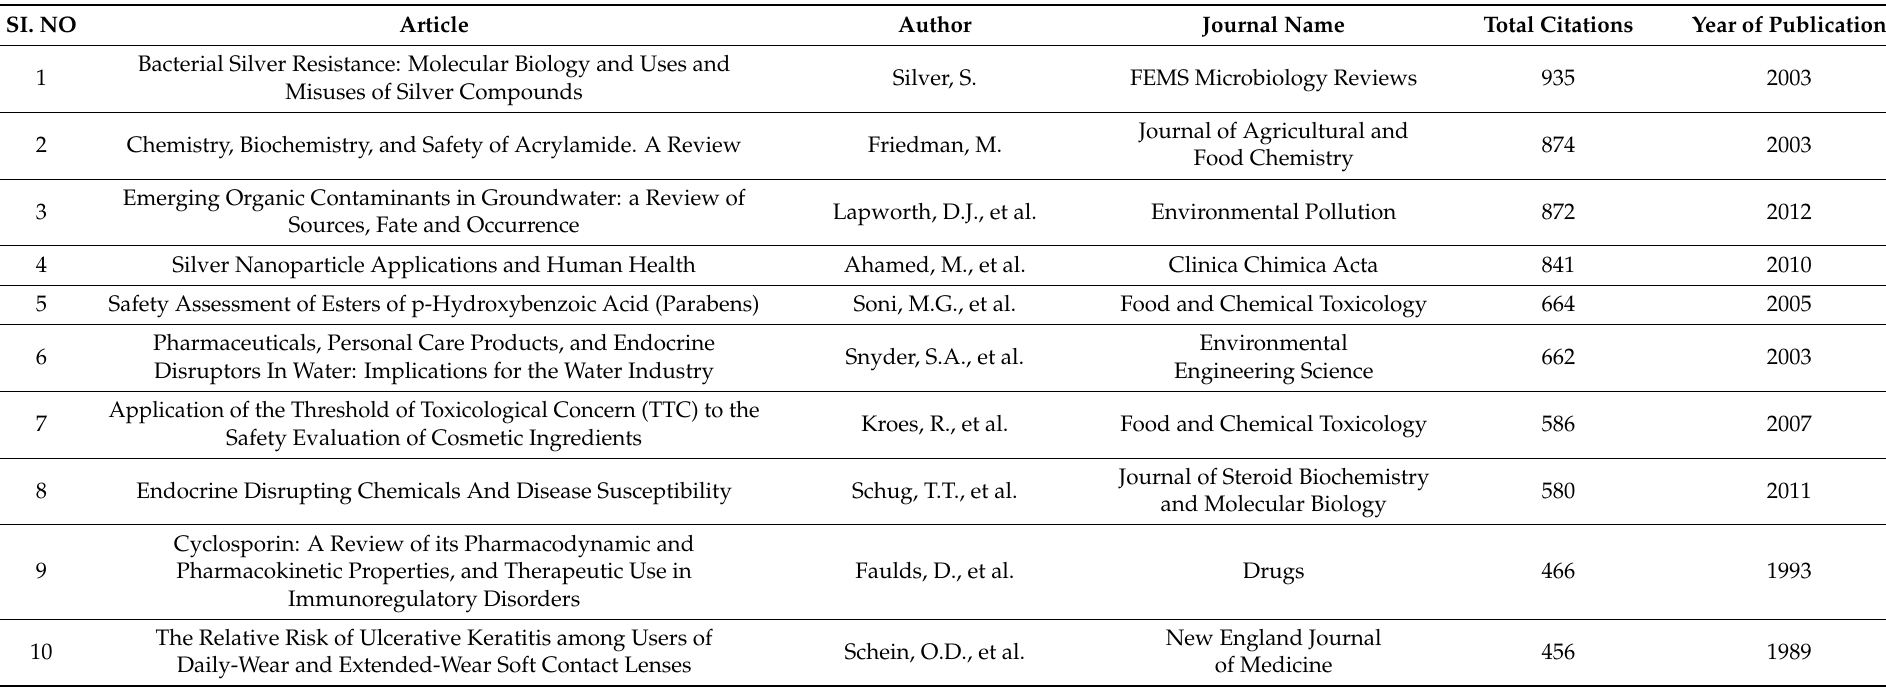
Table 6. The ten most cited publications in cosmetic adverse effects